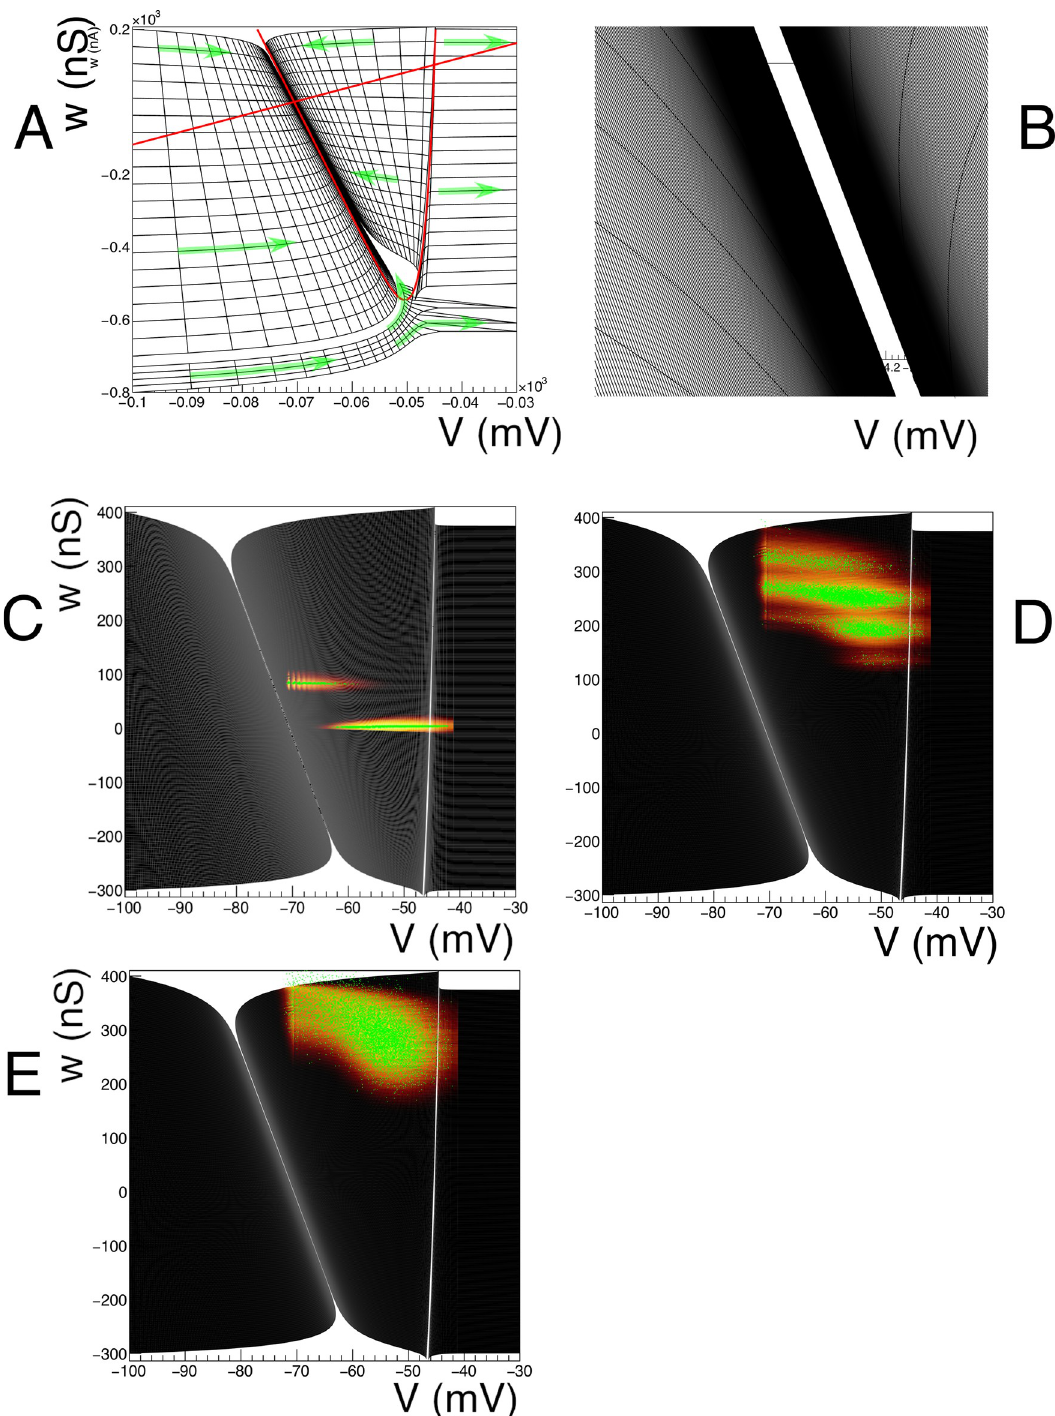
Fig 9. A: Overview of state space for the adaptive-exponential-integrate-and-fire neuron. B: a detail of a realistic mesh near the equilibrium potential. C-E: evolution of the probability density at t = 0.01, 0.1, 0.4s. The input (switched on at t = 0) is a Poisson distributed spike train of 3000 spikes/s, delta synapses with efficacy J = 1